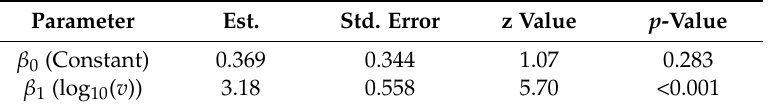
Table 6. Results from logistic regression with annoyance from vibration as the outcome, and with the decimal logarithm of the vibration velocity as the predictor (area 2, both noise and